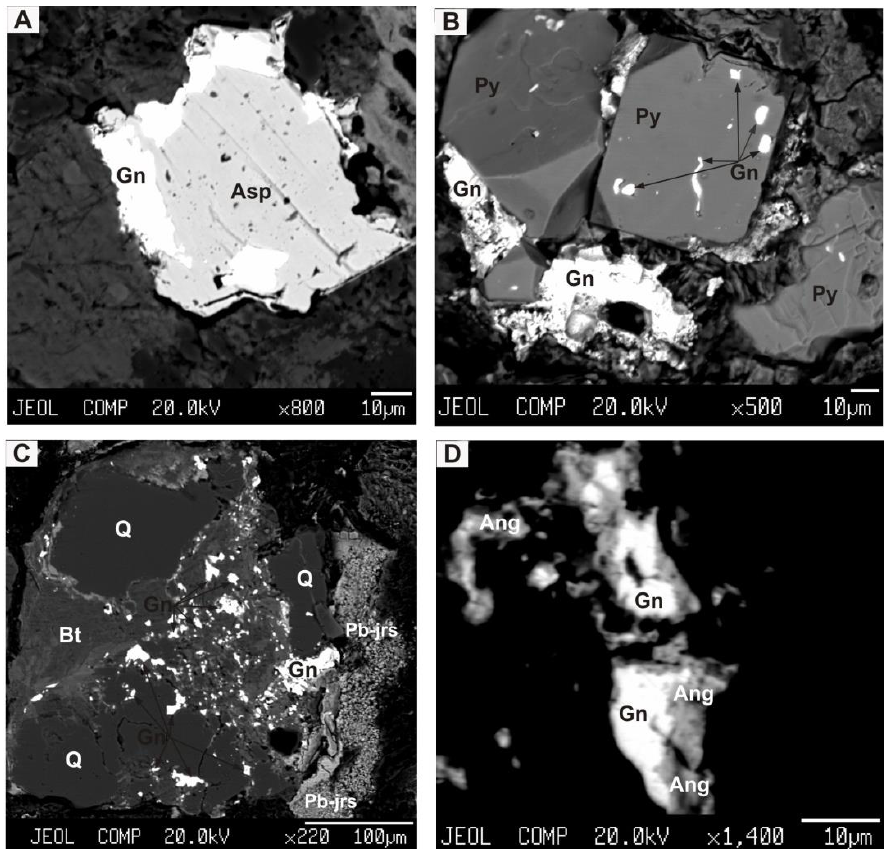
Figure 6. Relationship of minerals in dust particles: ( A ) galena (Gn) and arsenopyrite (Asp); ( B ) galena (Gn) and pyrite (Py); ( C ) galena (Gn), plumbojarosite (Pb-jrs), quartz (Q) and biotite (Bt); ( D ) galena (Gn) and anglesite (Ang). Photographs in backscattered electrons.